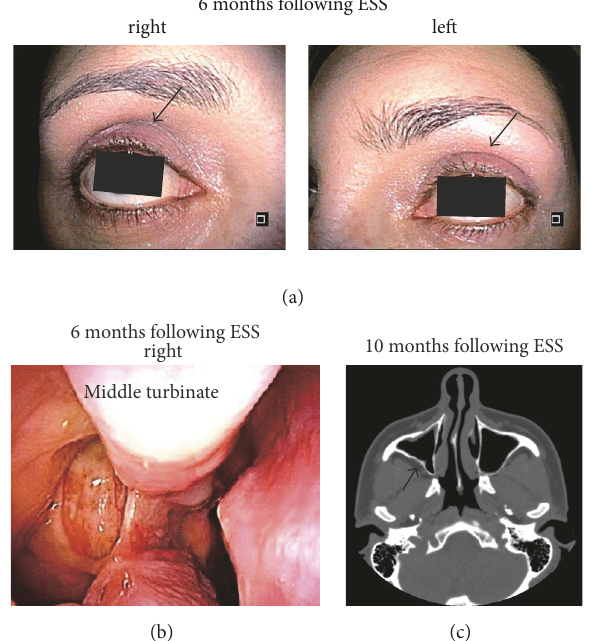
Figure 3: Summary of the clinical examination after the endoscopic sinus surgery. (a) Facial appearance 6 months after the endoscopic sinus surgery (ESS). The arrows in the right and left pictures show the superior sulcus. The deepening of the right superior sulcus that was observed before the sinus surgery appeared to have been eliminated by the ESS. (b) Endoscopic findings 6 months after the ESS. The right uncinate process was removed and recurrence of the deformity was not observed. (c) Computed tomography findings 10 months after the ESS. The deviation of the posterior wall in the right maxillary sinus (shown by the arrow) seems to have been eliminated by the ESS.